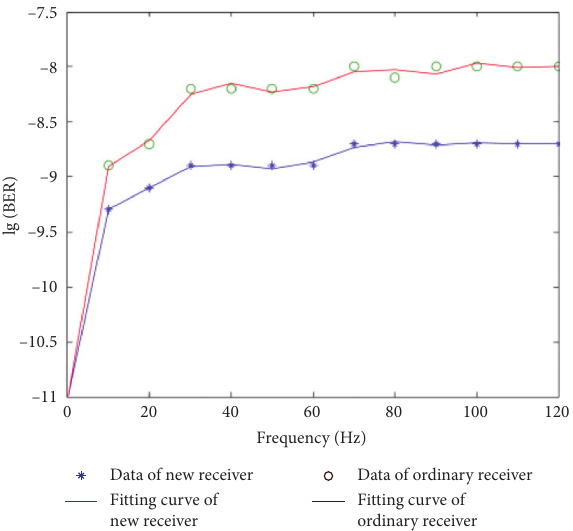
Figure 9: lg(BER) of both new and ordinary receivers (amplitude: 50 urad).